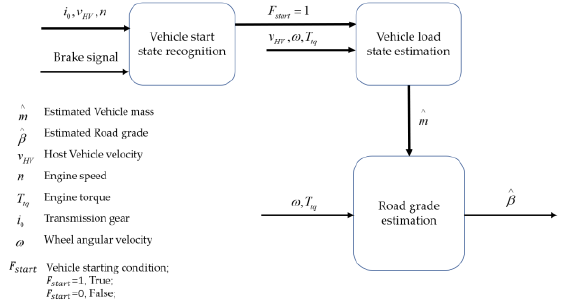
Figure 3. Vehicle load state and road grade estimation schematic.